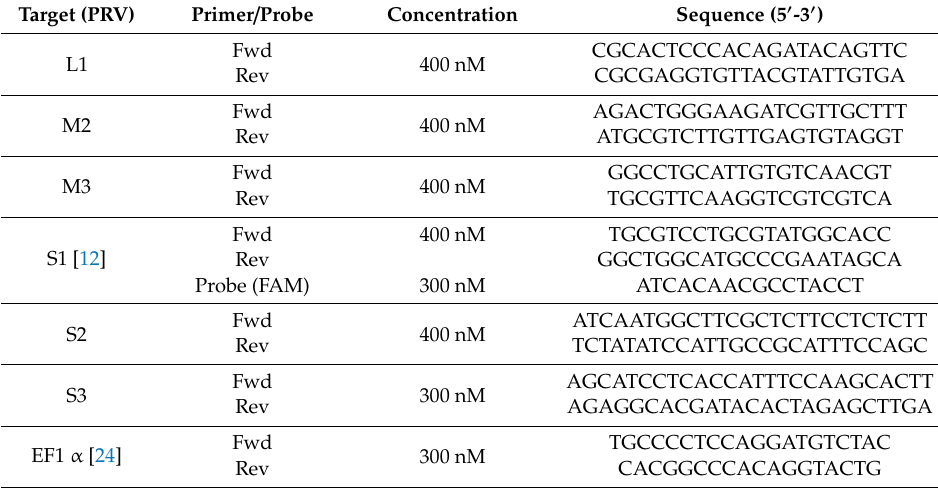
Table 1. Primer and probe sequences (5 (cid:48) -3 (cid:48) ) for various PRV gene